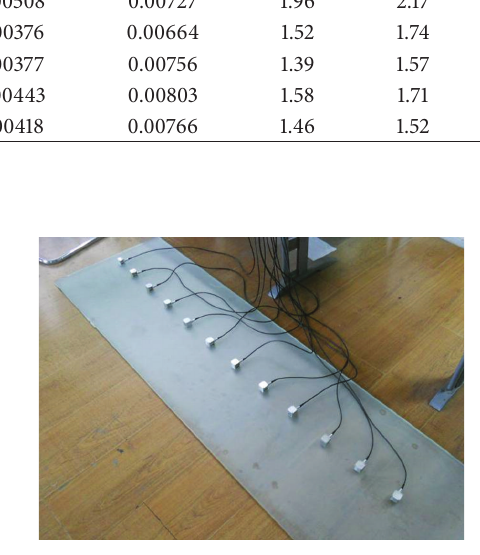
Figure 9: Microseism